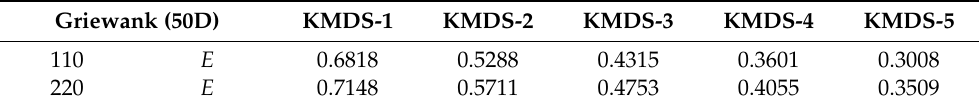
Table 2. The distance error between the original data and the low-dimensional data. Griewank